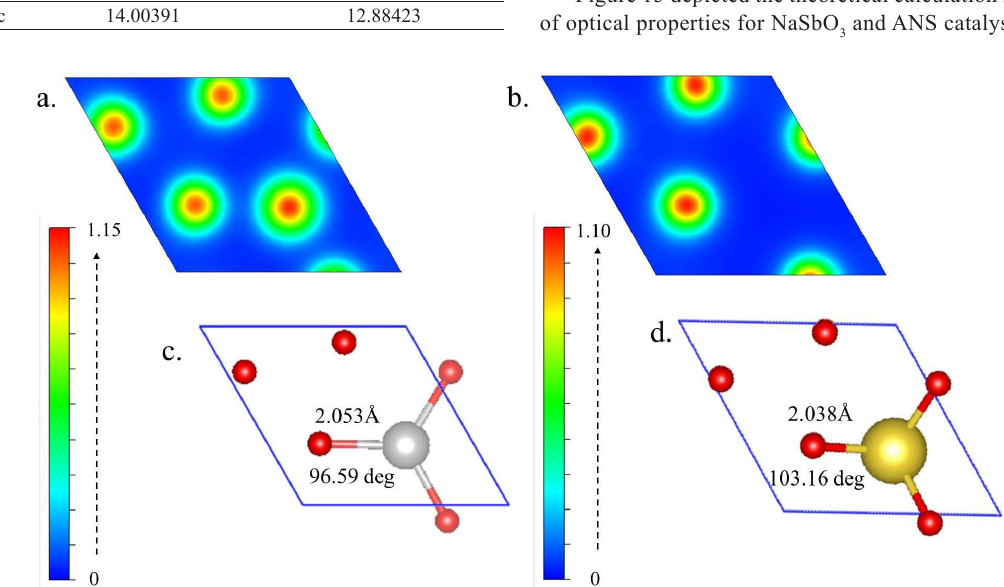
Figure 12. Charge density distribution (0 0 1 surface, distance from origin is 0.1d) of ANS Catalyst (a) and NaSbO